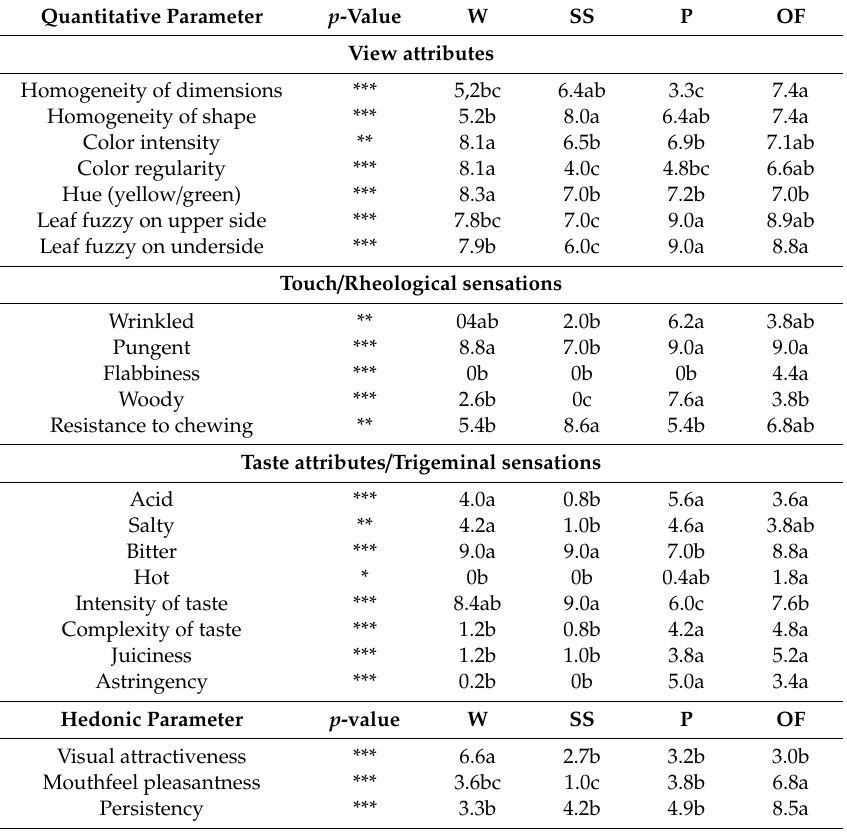
Table 3. Two-way ANOVA calculated for all quantitative and hedonic parameters evaluated by panelists during tasting sessions for Picris hieracioides . Only data that showed significant di ff erences ( p < 0.05) are reported. Means keyed with a di ff erent letter are significantly di ff erent for p = 0.05, considering each species independently and following one-way ANOVA, with wild-collection or the di ff erent domestications as the variability factor. Significance level: ***: p < 0.001 (F = 7.94); **: p < 0.01 (F = 4.77); *: p < 0.05 (F = 3.01).